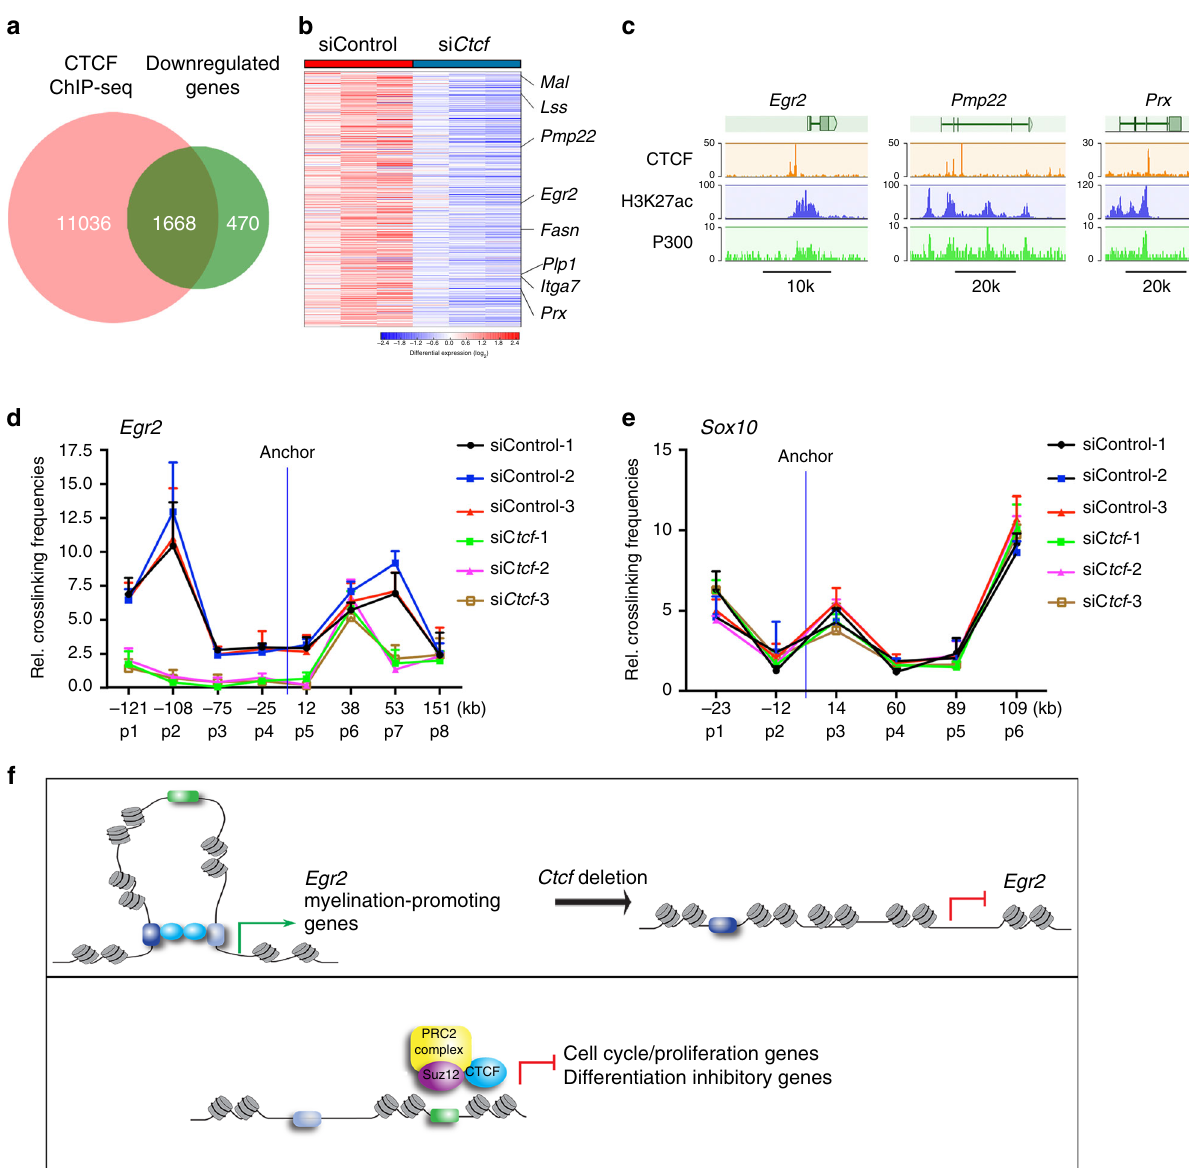
Fig. 10 CTCF-mediated chromatin regulatory looping is necessary for EGR2 expression. a Venn diagrams depicting overlap between CTCF-bound genes and downregulated genes differentially expressed in rat SCs treated with control siRNA or si Ctcf . b Heatmap of CTCF-targeted genes differentially downregulated in SCs treated with si Ctcf compared to controls. n = 3 in each condition. c Genome browser tracks over the loci of selected myelin-related genes with ChIP-seq density mapping of CTCF, H3K27ac, and P300 from rat SCs. n = 1 in each condition with 20 million cells. d Quantitation of relative interaction frequencies between the indicated anchor site and neighboring Egr2 genomic restriction fragments. n = 3 independent 3C experiments. e Quantitation of relative interaction frequencies between the indicated anchor site and neighboring Sox10 genomic restriction fragments. n = 3 independent 3C experiments. f A model depicting a dual mode of action by CTCF in promotion of SC differentiation: CTCF stabilizes chromatin loops involving promotor-enhancer interactions to activate expression of promyelinating genes such as Egr2 (left panel) and forms a transcriptional co-repressor complex with SUZ12-PRC2 (right panel) to inhibit expression of genes such as Sox2 that encode factors that inhibit differentiation and cell-cycle/ proliferation regulators. Data are presented as means ± SEM. Source data are provided as a Source Data fi